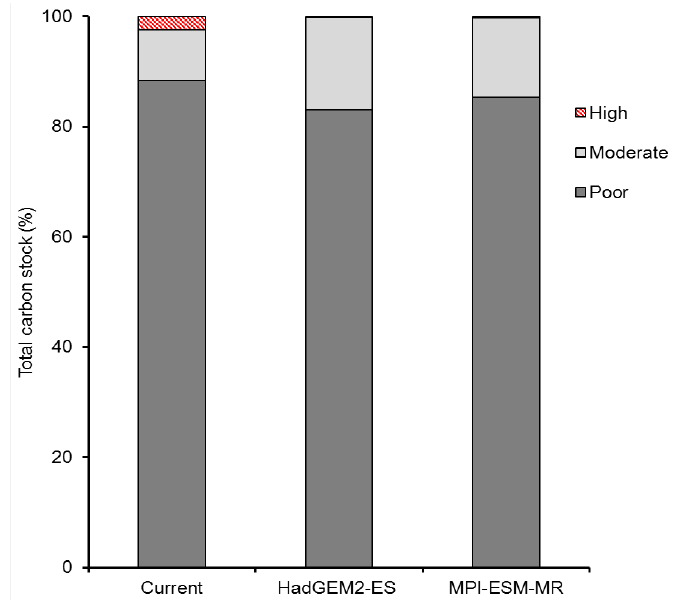
Figure 7. Suitable areas predicted under current and future climate models.